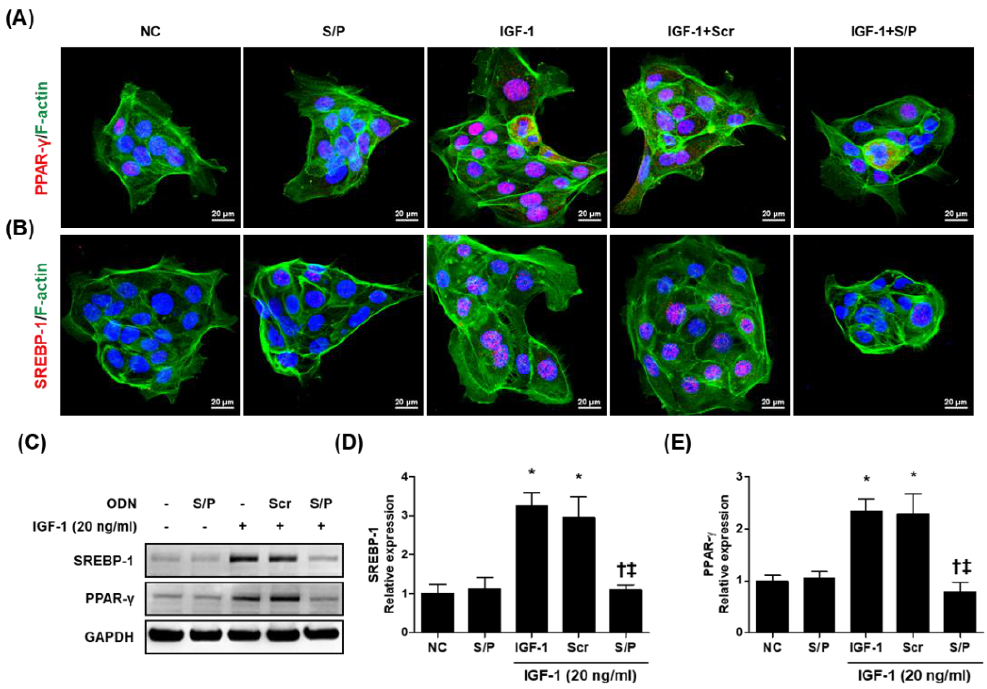
Figure 6. The SREBP/PPAR chimeric decoy ODN influenced the expression of PPAR- γ and SREBP-1 in IGF-1-stimulated SZ95 cells. Representative immunofluorescence images of ( A ) SREBP-1 and ( B ) PPAR- γ (labeled with Alexa Fluor 555, red). F-actin was labeled with Alexa Fluor 488 (green). DAPI (blue)-stained nuclei. ( C ) Representative Western blot analysis results showing that the SREBP/PPAR chimeric decoy ODN inhibited the IGF-1-induced PPAR- γ and SREBP-1 expression. ( D , E ) Graphs showing the quantitative signal intensities of SREBP-1 and PPAR- γ. * p < 0.05 compared with the NC. † p < 0.05 compared with the IGF- 1. ‡ p < 0.05 compared with the IGF-1+Scr.